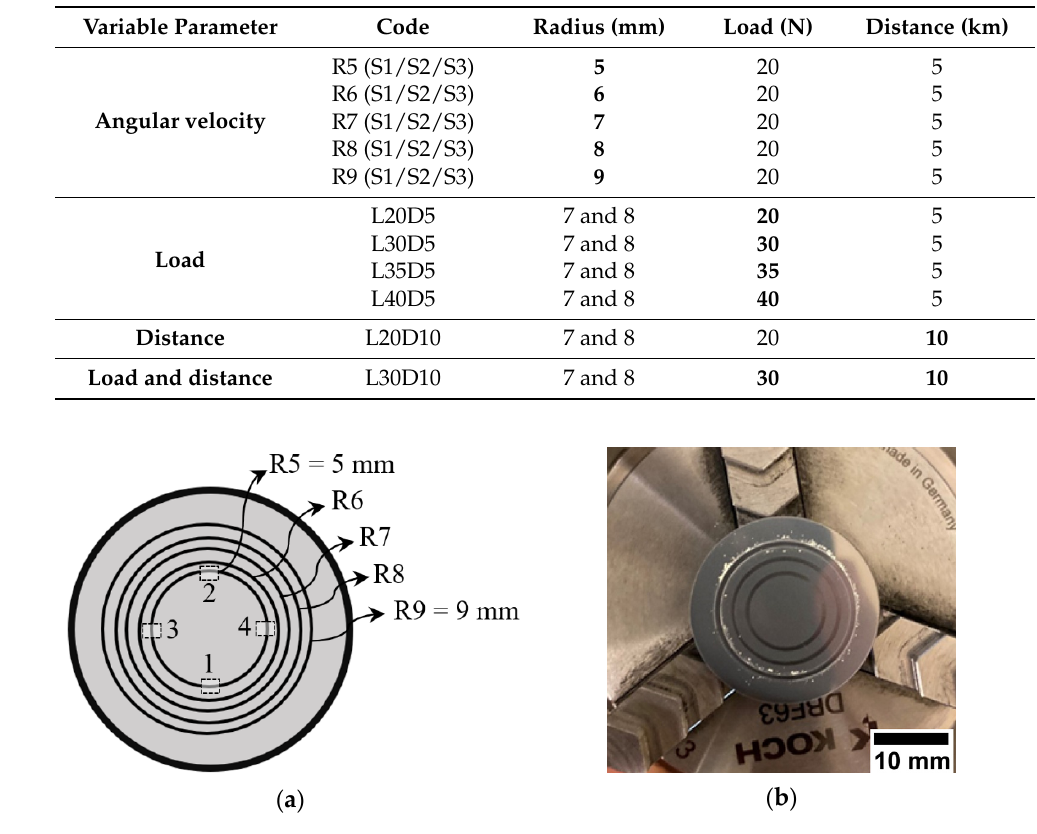
Figure 1. ( a ) Schematic diagram of different radii and distinct locations for volume loss measurements on the testing samples, and ( b ) a typical sample after ball-on-disk test.